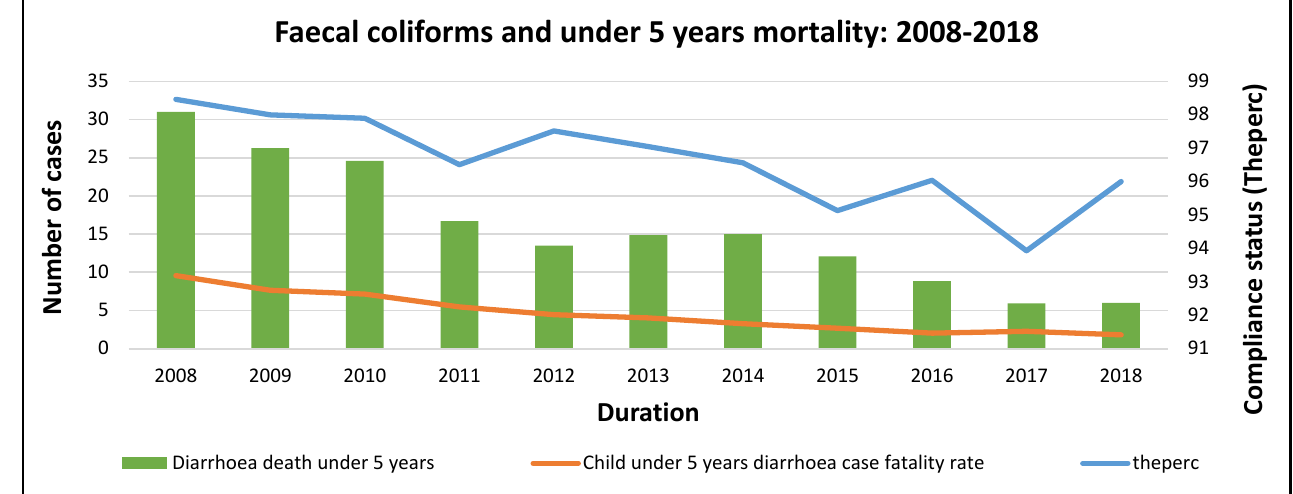
Figure 5. Faecal coliforms and mortality trends at the national level. E. coli are defined as microorganisms that have the ability to ferment lactose with the production of both acid and gas at 44 °C, as defined in SANS 241:2015 Edition 2 [1,2]. E. coli is listed as an indicator organism for drinking water quality measured in count per 100 mL, and a standard limit has not yet been detected [1,2].